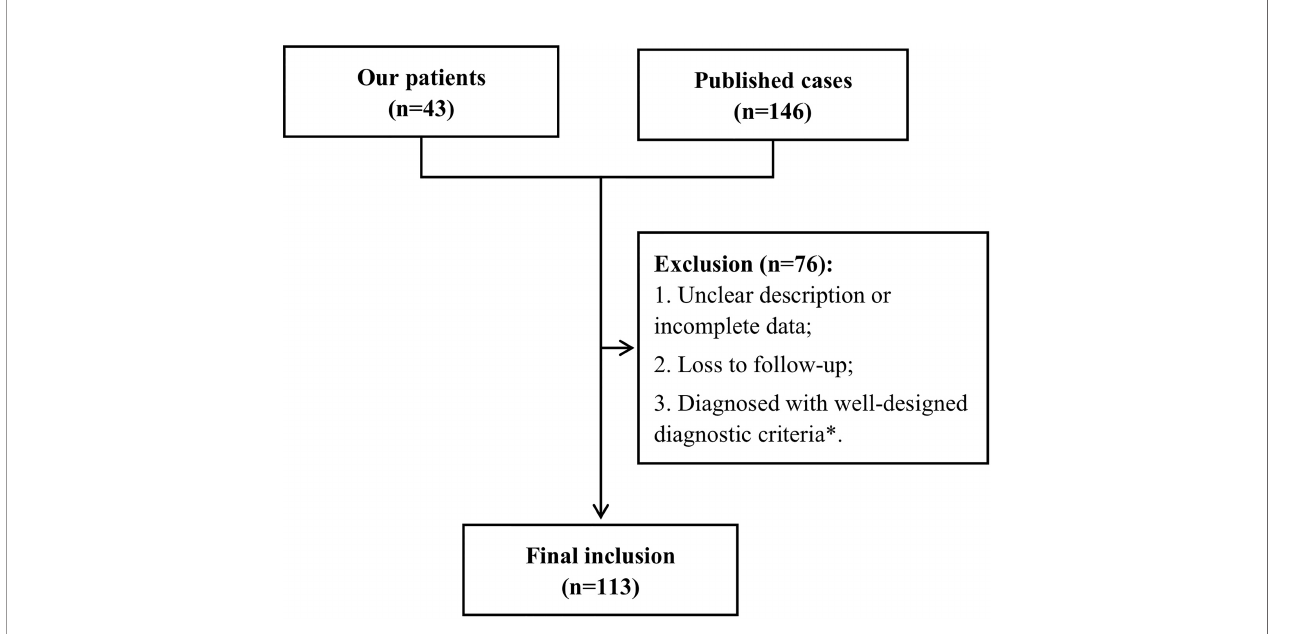
FIGURE 1 | Flowchart. *Diseases occurred in association with cancer but had well-designed diagnostic criteria (10), including in fl ammatory myopathies (dermatomyositis, polymyositis, and necrotizing myopathies), myasthenia gravis, and polyneuropathies associated with monoclonal gammopathies, and paraneoplastic retinopathy, optic neuritis, and cochlear